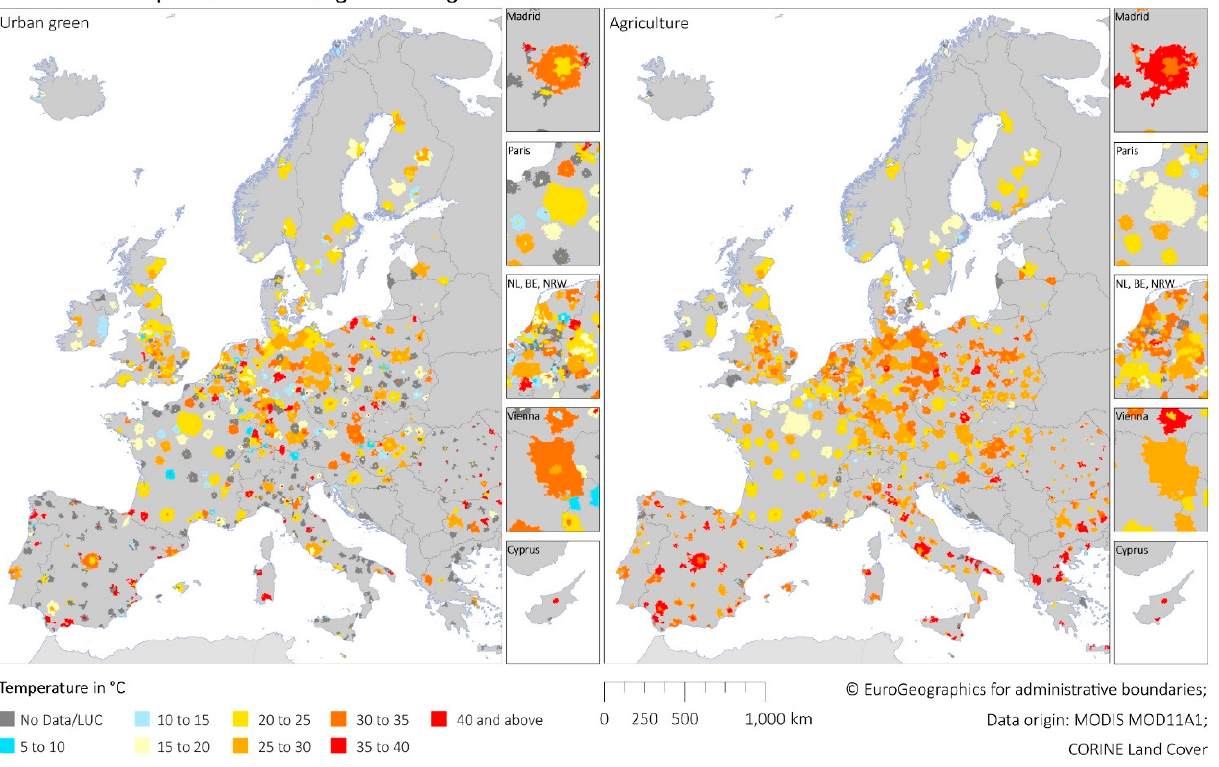
Figure 11. LST of urban green and agricultural areas, 2000.